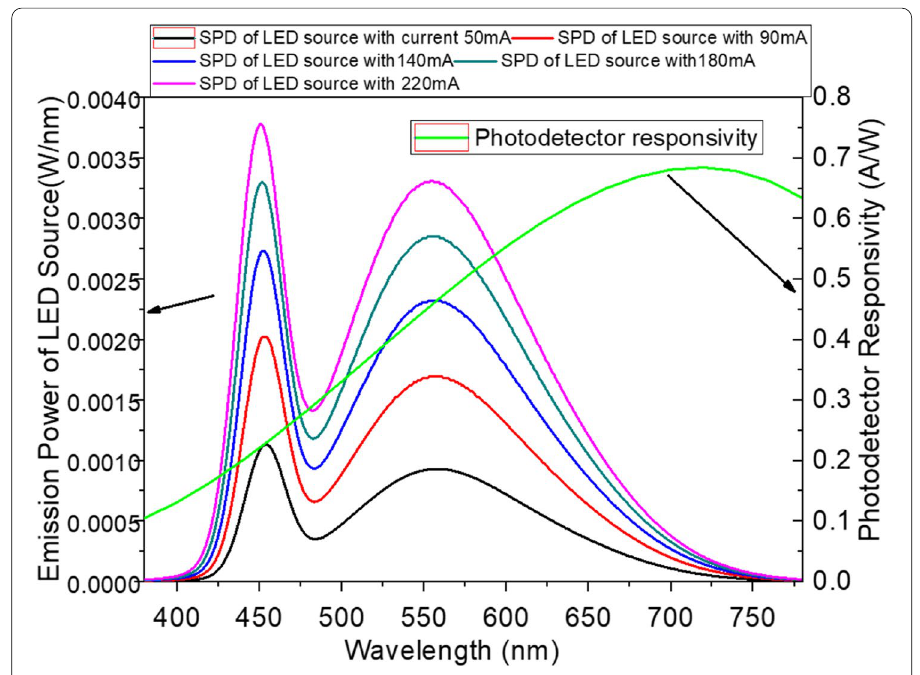
Table 1 Required coefficients for proposed model of cool white LED Coefficient Value Coefficient Value Coefficient Value 0.3 χ 2,c 5.3 c 3,c 130.5 α 1,c − α 2,c 147.5 c 2,c 125.3 μ 1,c 0.00005 − β 1,c 97.7 δ 1,c 5.31 μ 2,c 0.0041 − β 2,c 355.1 δ 2,c 178.2 μ 3,c 124.2 − c 1,c 128.5 ε 1,c 103.4 c 4,c 129.7 347.2 c 5,c χ 1,c 155.7 ε 2,c −